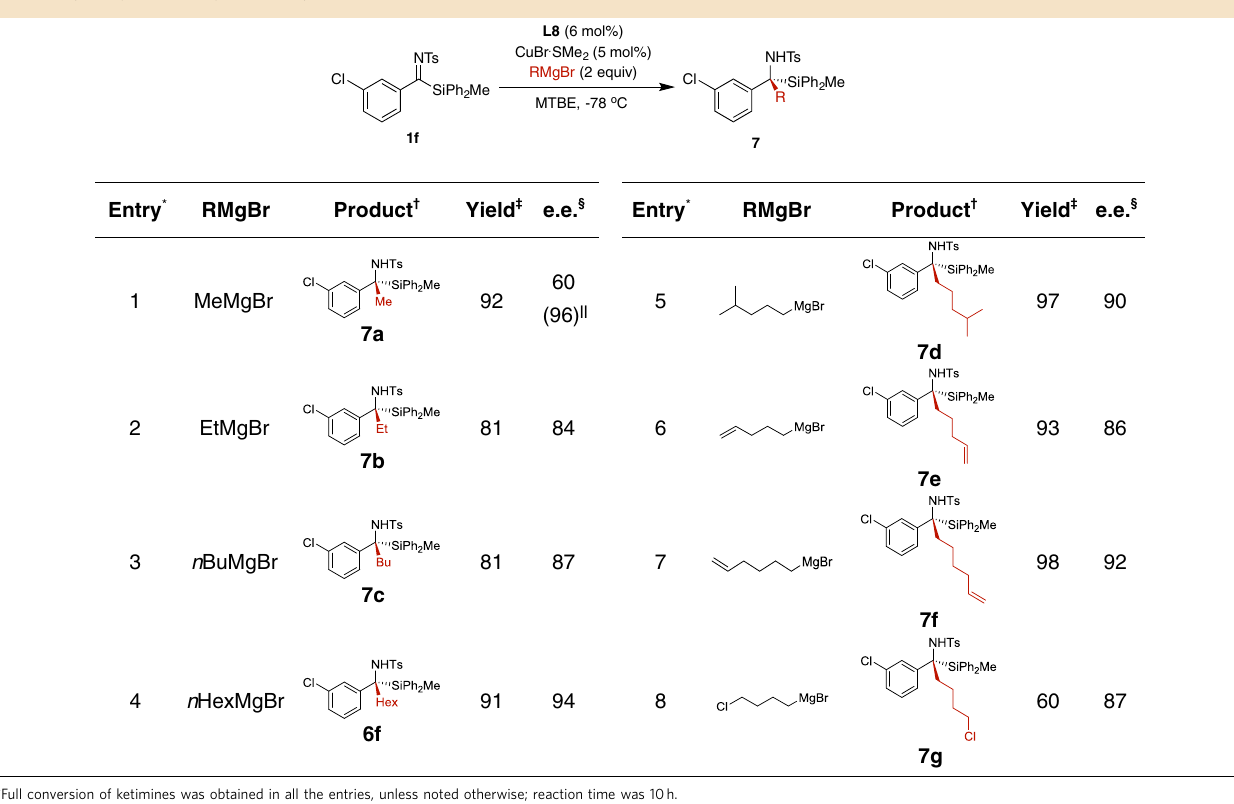
Table 3 | Grignard reagents